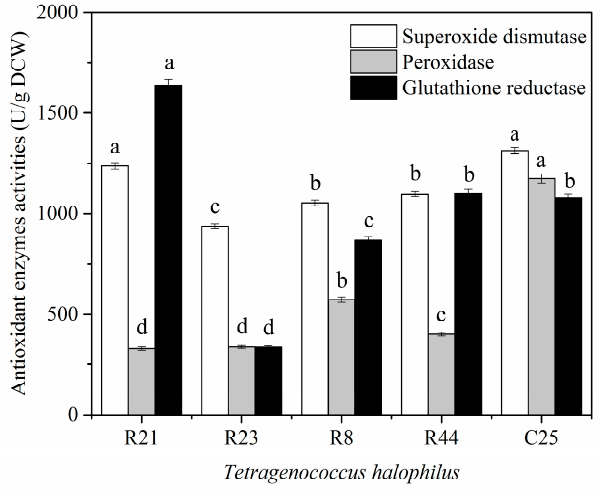
Figure 2. Comparison of the antioxidant enzymes produced by T. halophilus strains. Different lowercase letters indicate significant differences among different groups ( p < 0.05).